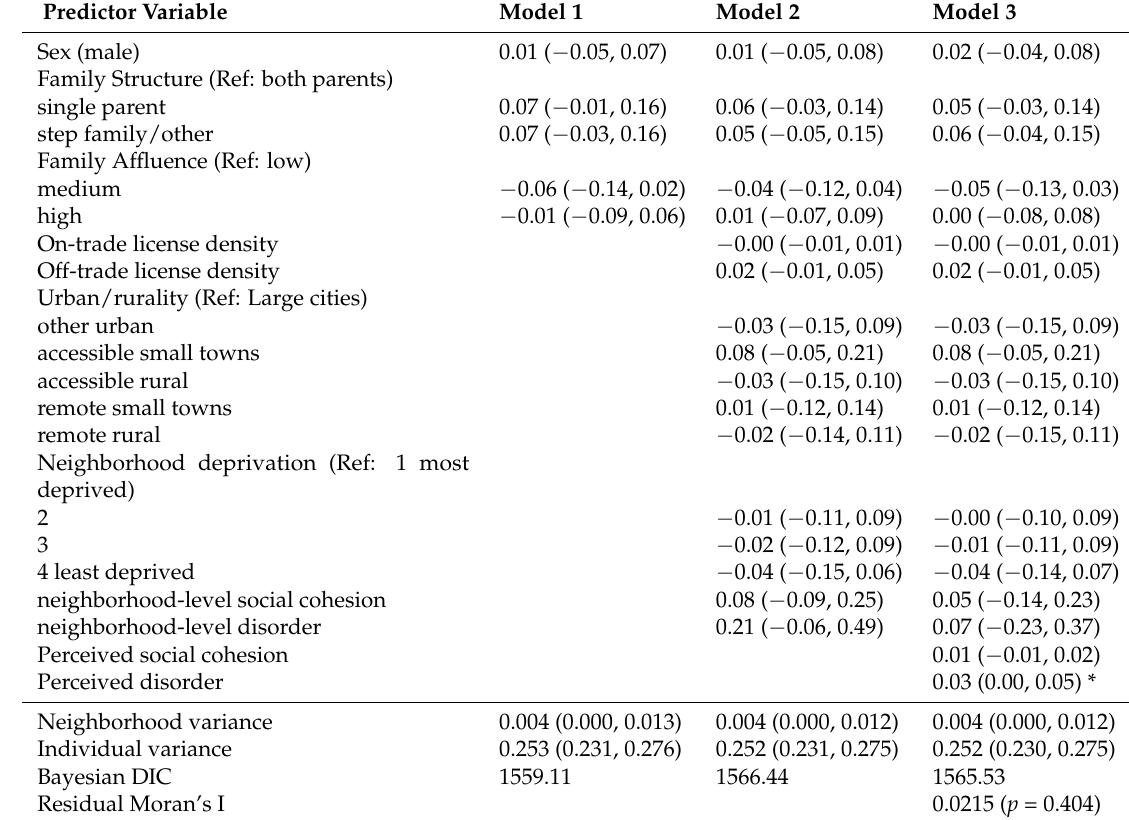
Table A2. Social motives regressed on neighborhood and individual measures (95% credible intervals) n = 1051 (Intermediate Data Zones n =